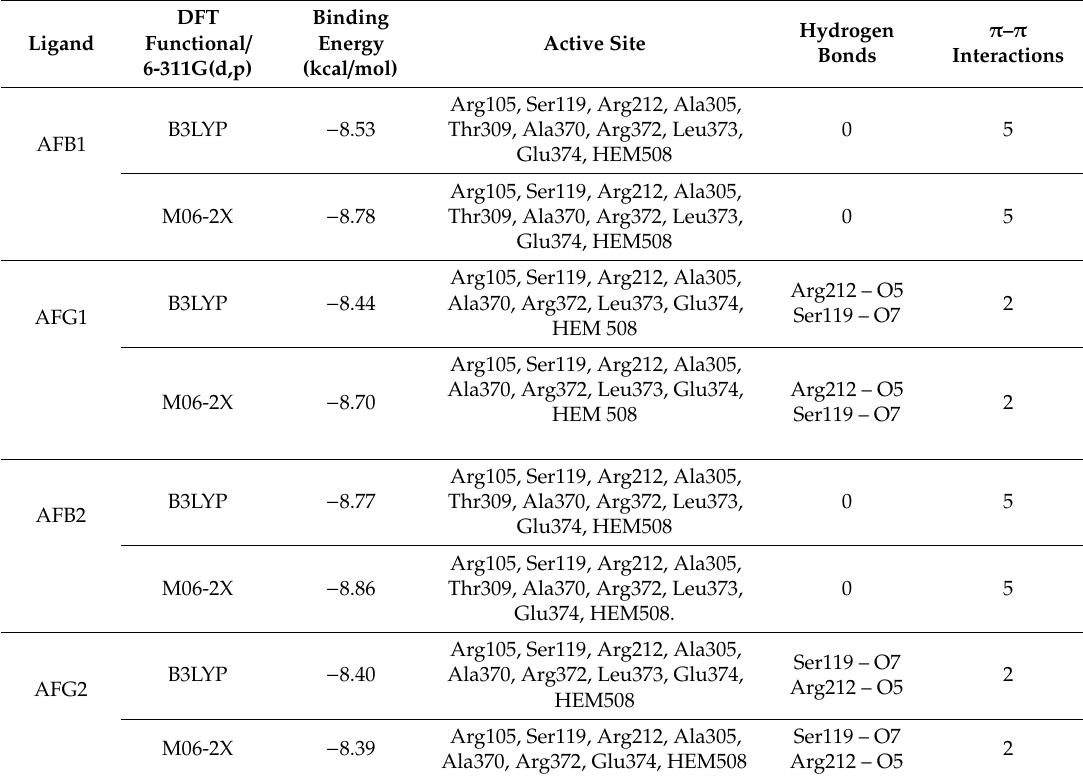
Table 2. Analysis of the molecular interactions between CYP3A4 (1TQN PDB ID) and aflatoxins provided by molecular docking